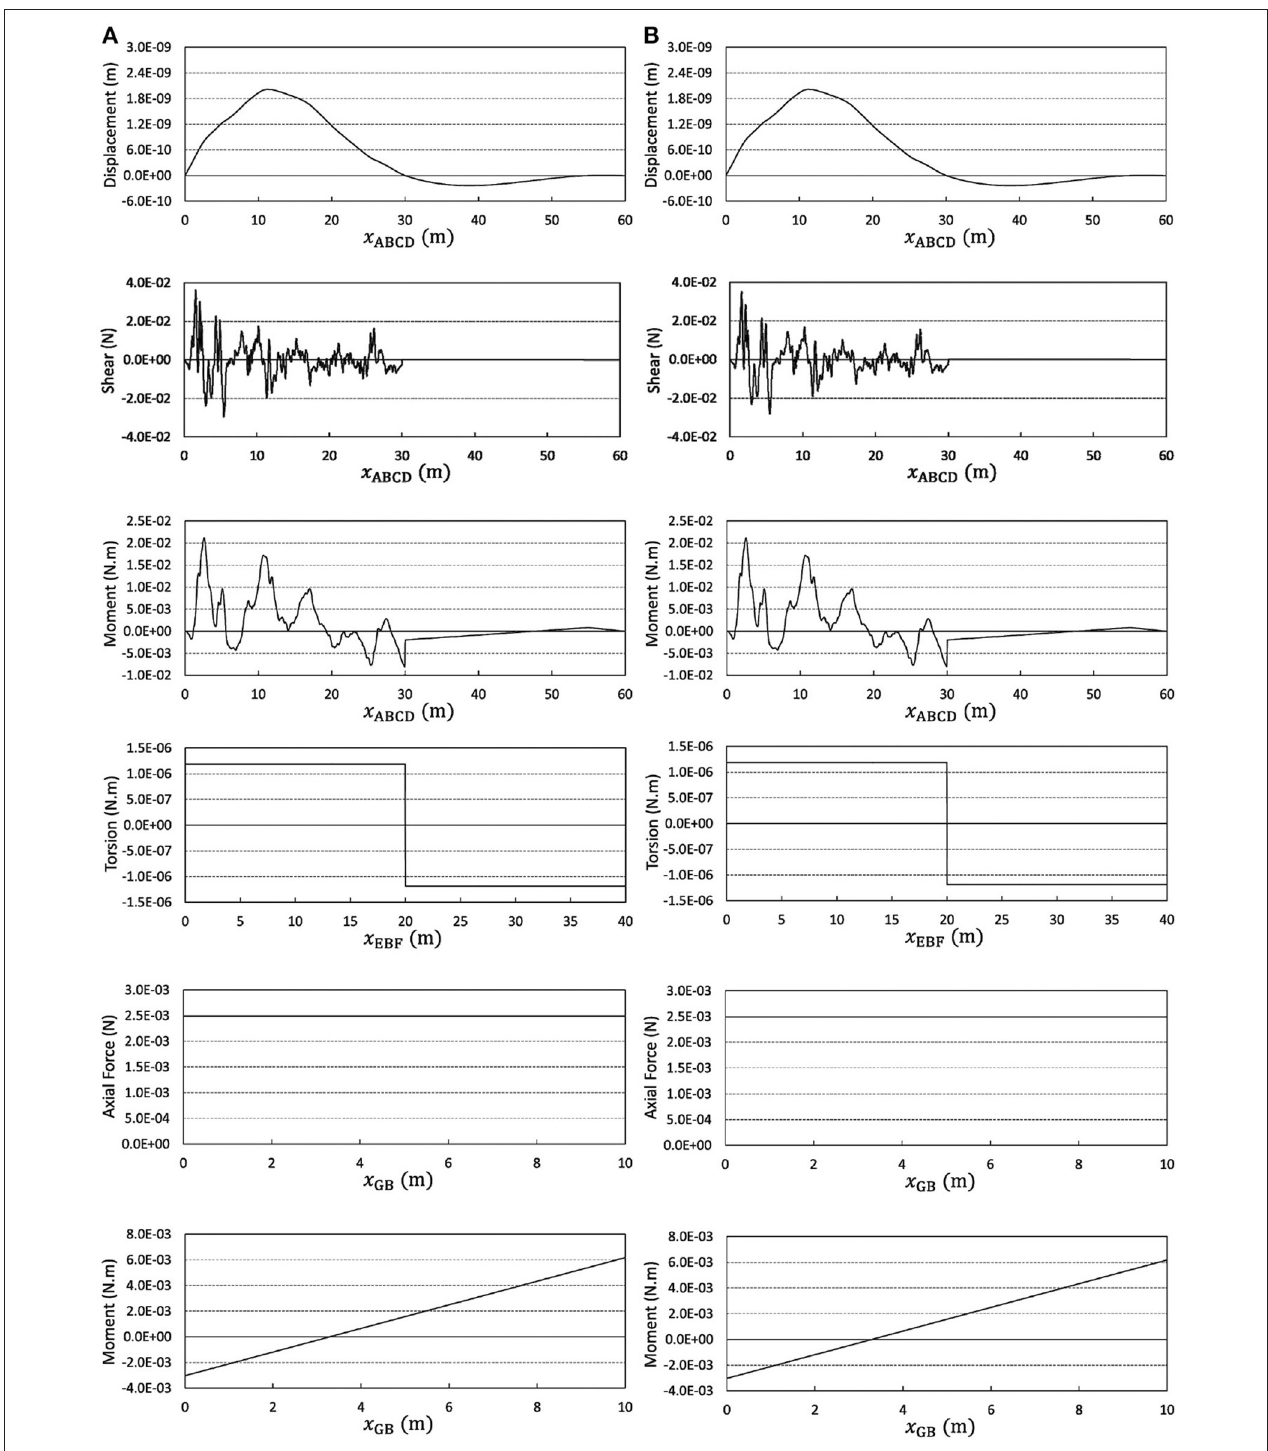
FIGURE 14 | A consequence of the replacement addressed in Figure 13 (A) analysis with elements sized f 1 x and (B) analysis with elements sized 2 f 1 x .